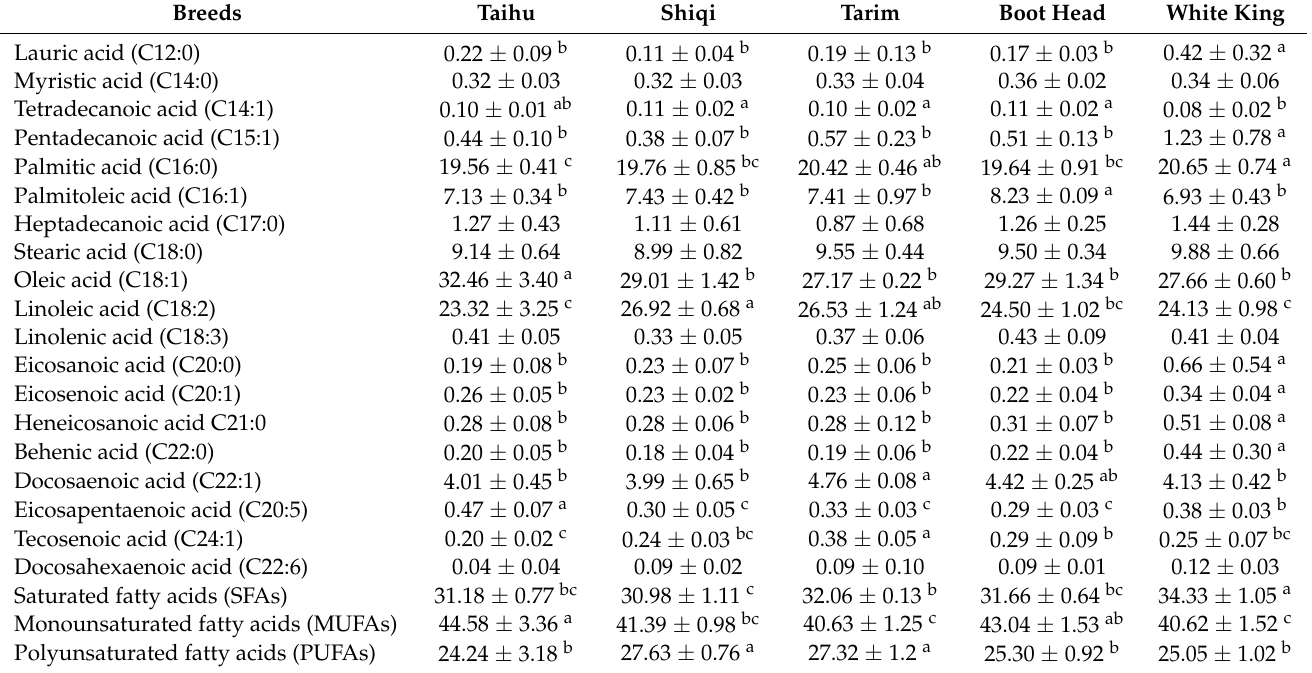
Table 4. Comparison of fatty acid contents between different breeds of pigeons